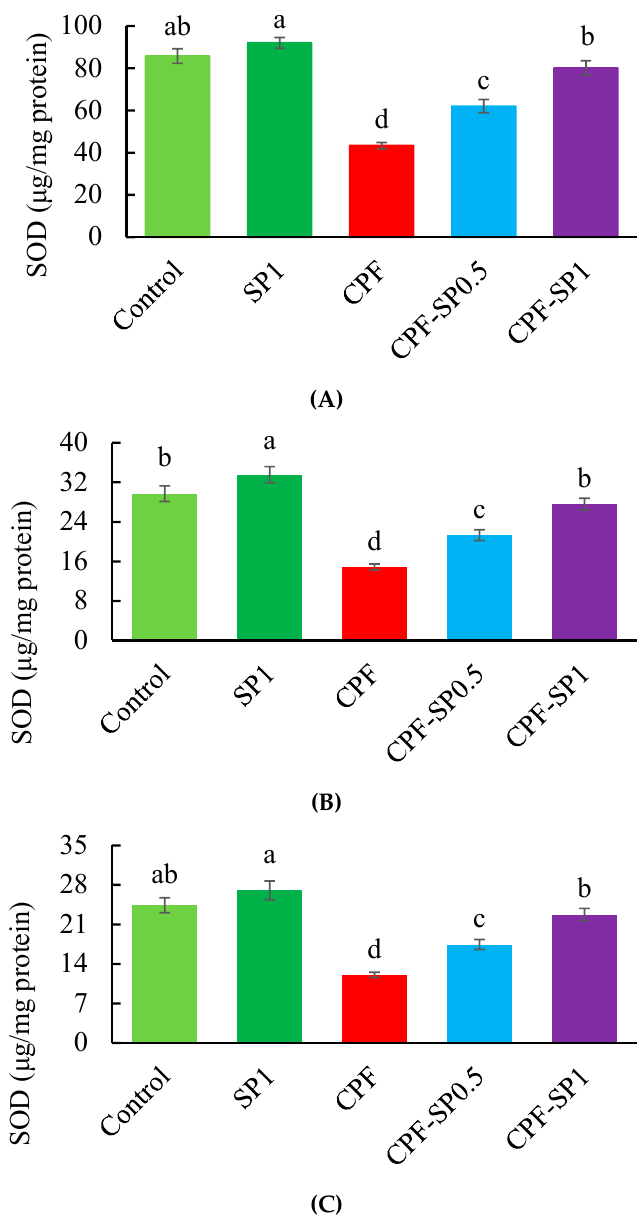
Figure 2. ( A ) Liver, ( B ) kidney, and ( C ) gill superoxide dismutase (SOD) levels in the treated groups ( μ g/mg protein). Data are presented as means ± SE ( n = 8). Bars with different letters are significantly different ( p ≤ 0.05).